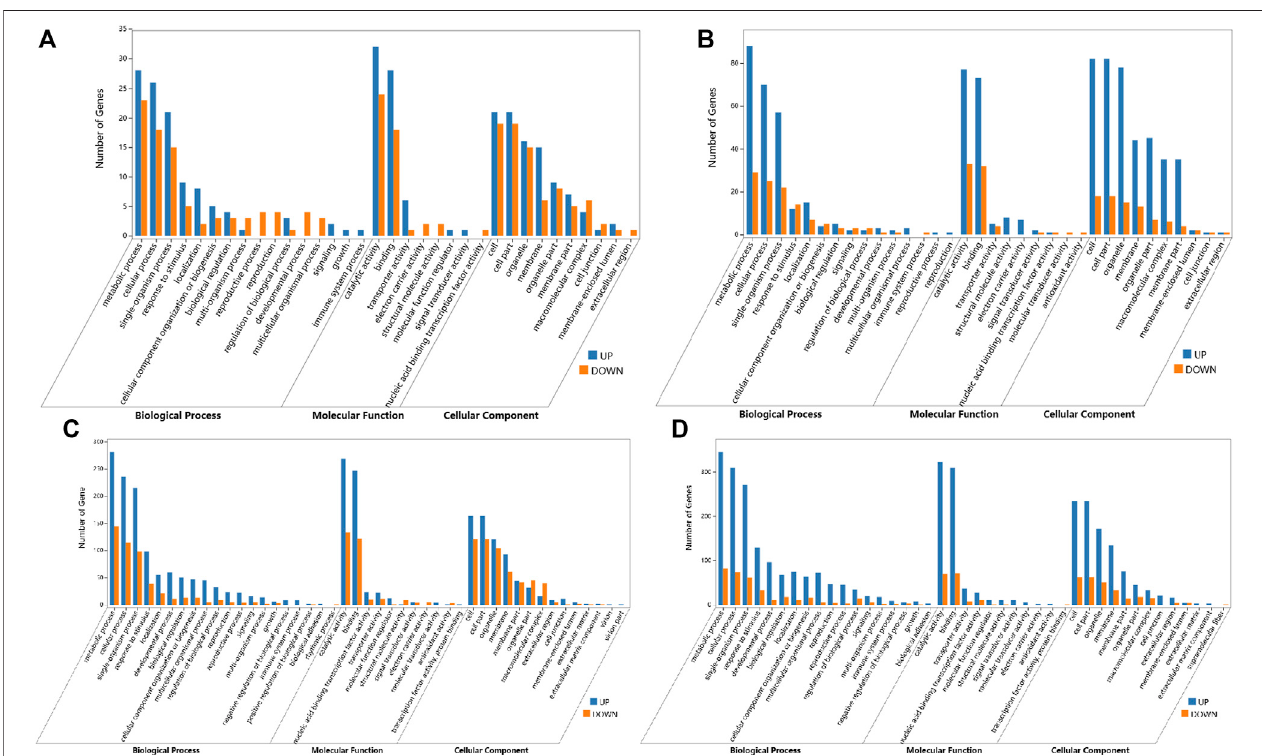
FIGURE 4 | GO annotations of DEGs from comparisons of the ABJ01 and 9# transcriptomes for poplars grown in Daqing and Qiqihar. Level2 GO annotation of DEGs from theDA vs. DB comparison (A) ; the QAvs. QBcomparison (B) ; the DA vs. QA comparison (C) and theDB vs. QB comparison (D) . Thetop GOterms in each comparison are shown for the three major GO ontologies “ Biological Process, ” “ Molecular Function, ” and “ Cellular Component. ” Up, upregulated DEGs; DOWN, downregulated DEGs.